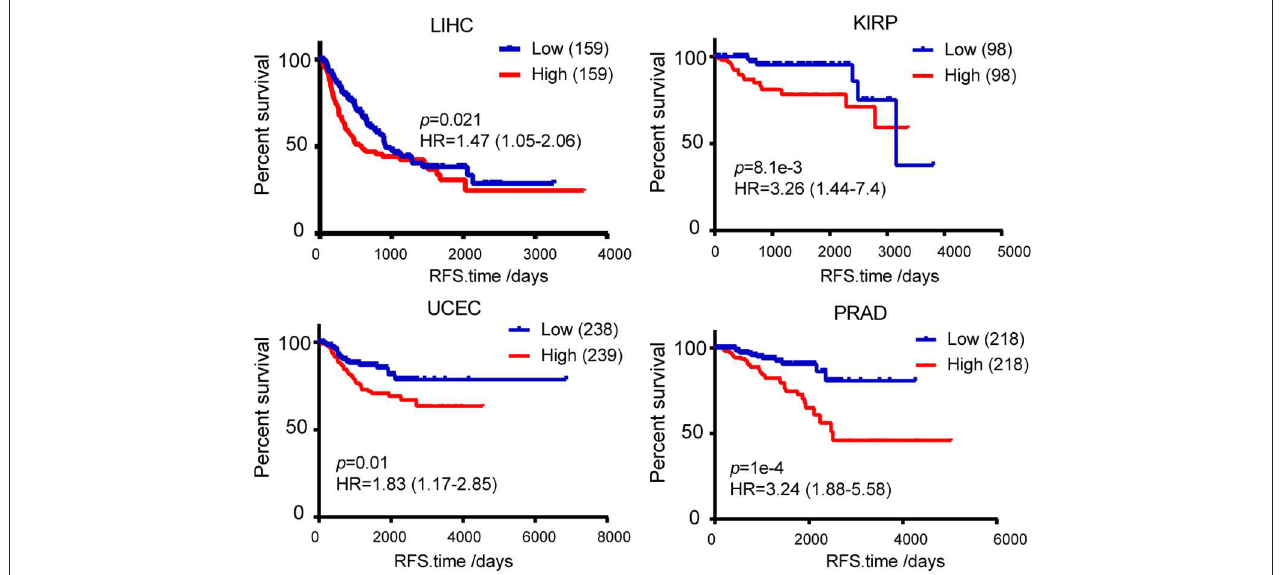
FIGURE 10 | Kaplan-Meier survival analysis was used to analyze the association between TICRR expression and patient disease free survival in LIHC, KIRP, UCEC, and PRAD. Median of TICRR mRNA expression was used to group and p -value was calculated using log-rank tests. HR, Hazard Ratio.